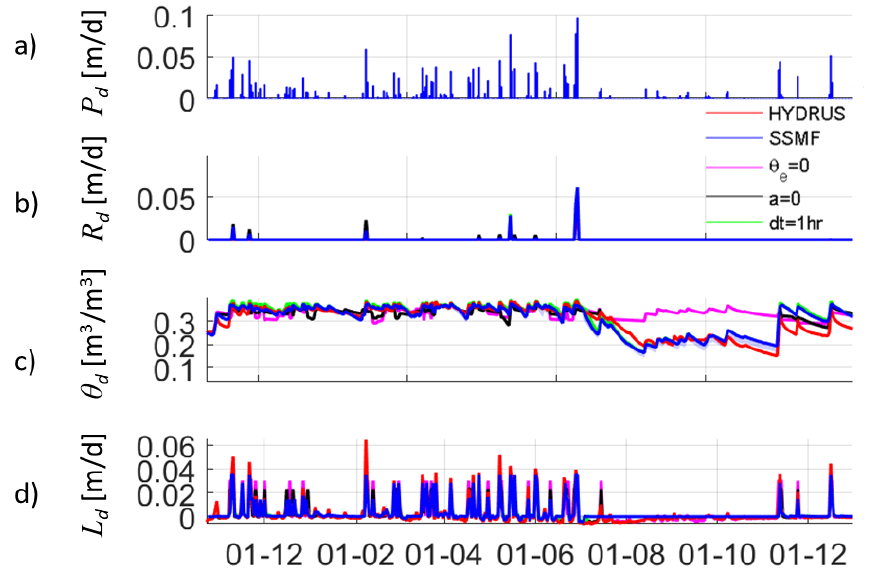
Figure 6. Influence of ignoring θ e or a , or setting dt to a relatively fast 1 h interval on SSMF performance versus HYDRUS. The outputs are ( a ) daily observed precipitation, ( b ) overland flow R d , ( c ) soil water content θ d and ( d ) vertical flux L d for the CZO clay at z r = 0.30 m. In ( b – d ), the time series are obtained from the calibrated HYDRUS software (red) and from the Shallow Subsurface Modelling Framework (SSMF, blue), as well as for the SSMF, for which one of those parameters was ignored: θ e (pink line), a (black line), and dt dry and dt sat (green line).